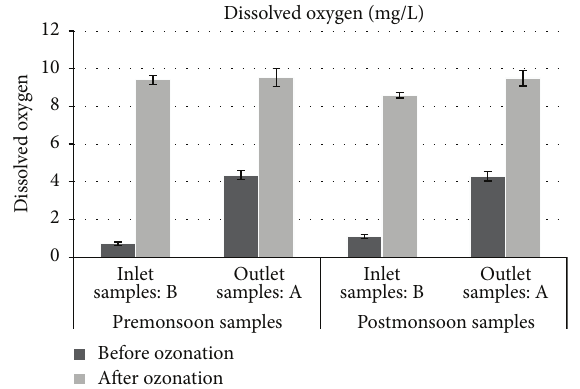
Figure 4: Dissolved oxygen of inlet and outlet samples before and after treatment by ozone.